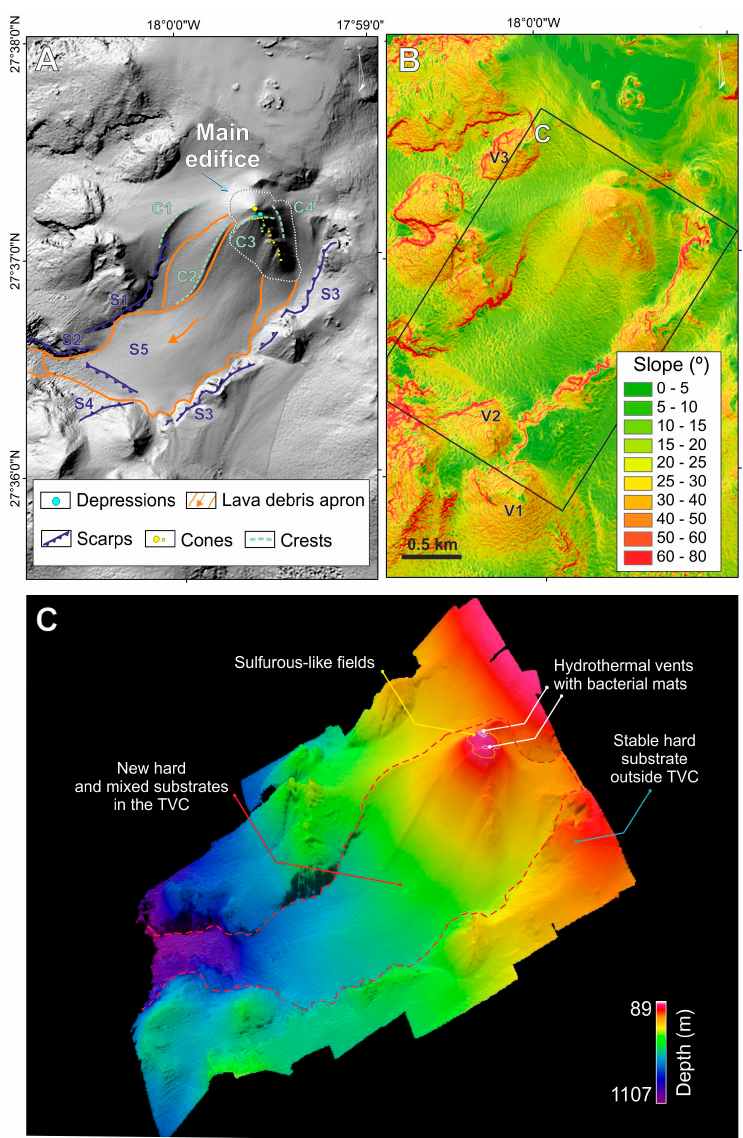
Figure 2. Main geomorphic features and related habitats of the Tagoro Volcanic complex. ( A ) Hillshade map showing the main geomorphological characteristics of the volcano. ( B ) Slope map highlighting similar volcanic cones (V1, V2, and V3) around the Tagoro Volcano. ( C ) 3D bathymetric map showing the location of the main habitats in and around the Tagoro Volcanic complex.